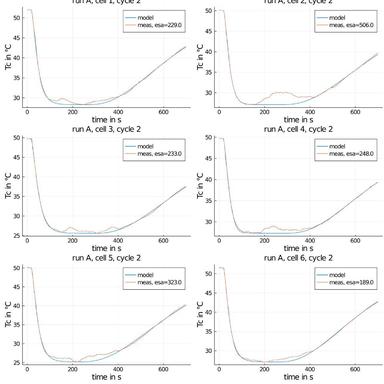
Temperature profiles in run A, second drying cycle.